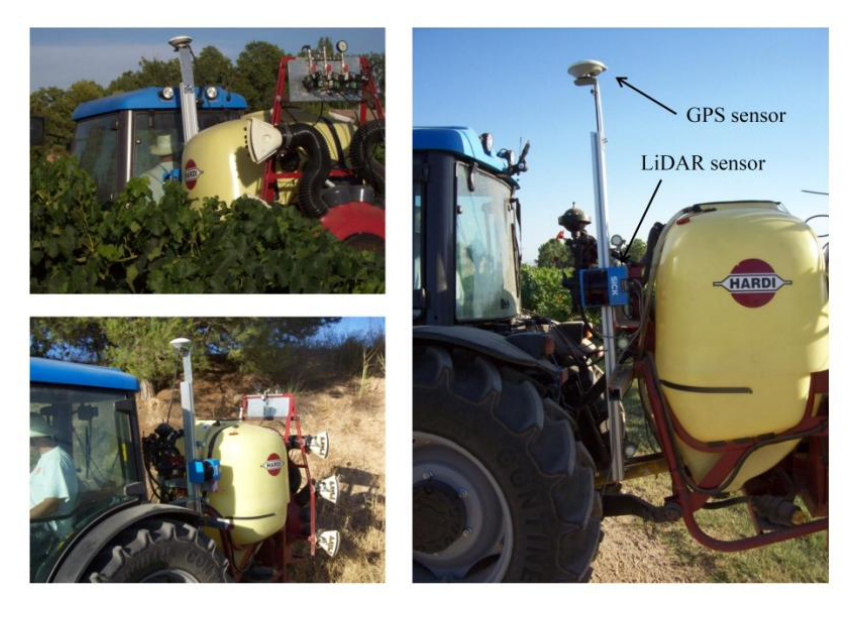
Figure 2. The LiDAR sensor and GPS receiver installed on the tractor for canopy